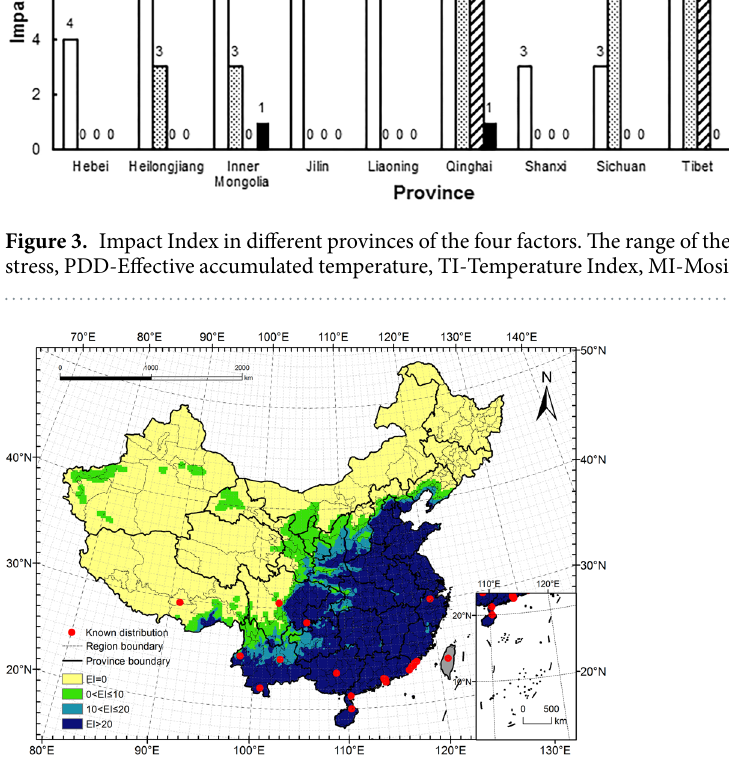
Figure 4. Potential distribution for Euwallacea fornicates under the current climate (1981–2010). Yellow regions indicated unsuitable habitats (EI = 0), green regions indicated marginally favorable habitats (0 < EI ≤ 10), turkish blue regions indicated favorable habitats (10 < EI ≤ 20) and deep blue regions indicated highly favorable habitats (EI > 20). The red points showed the locations of the known distribution in China. The grey regions (Taiwan) were not analyzed. The CLIMEX results were exported into GIS software (ArcGIS for Desktop, Software Version 10.2, http://resources.arcgis.com/en/home/) to generate the map in this